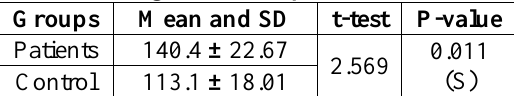
Table 4: The Mean and SD of serum Anti-SSA (ng/ml) in SSc patients.